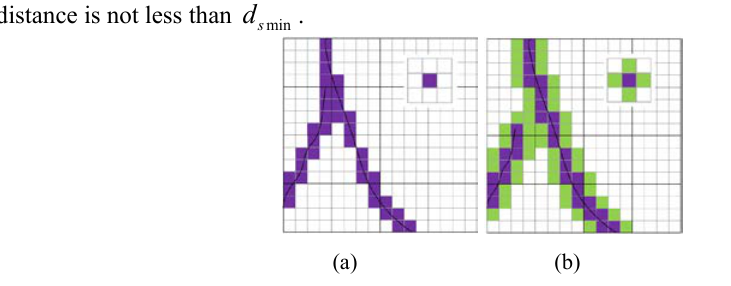
Fig. 1. Comparisons between unmarked and marked streamlined four-connected